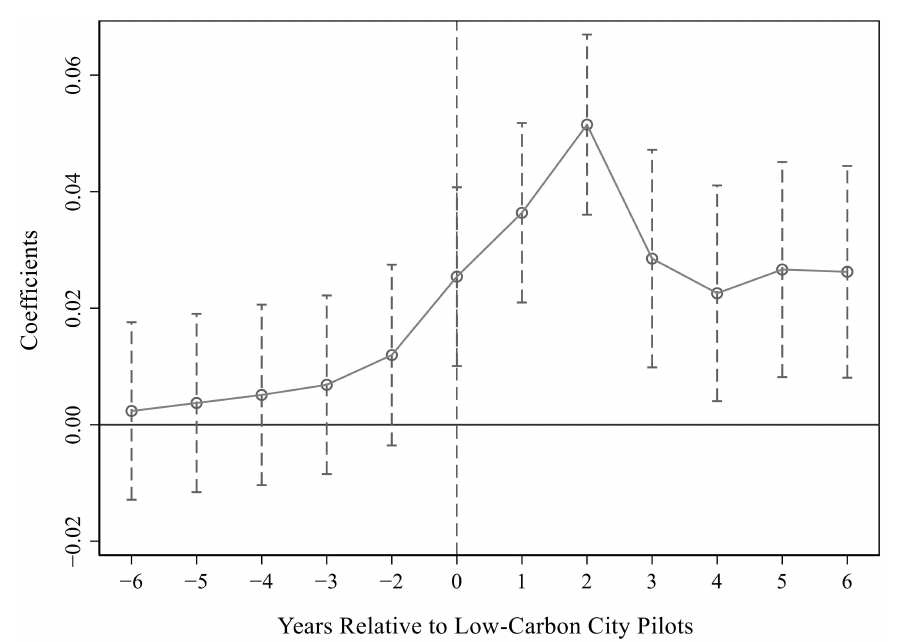
Figure 1. Parallel trend test in the first column of Table